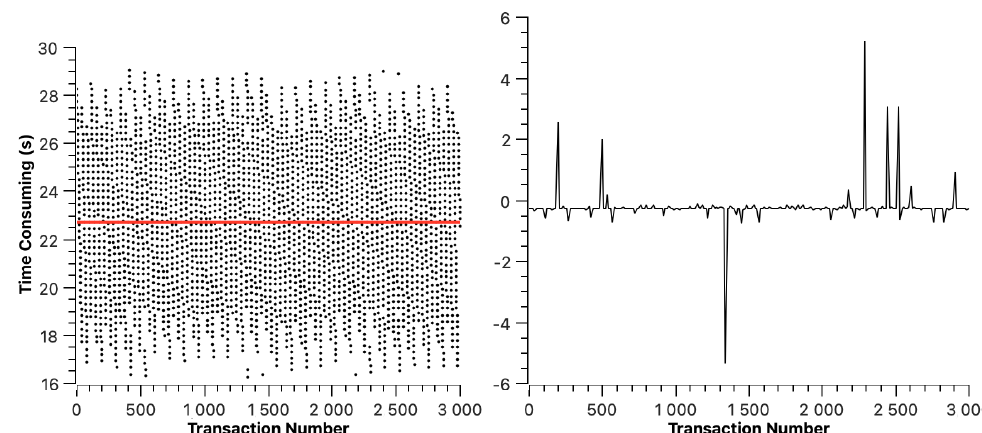
Figure 9. CITA cross-chain transaction resolution